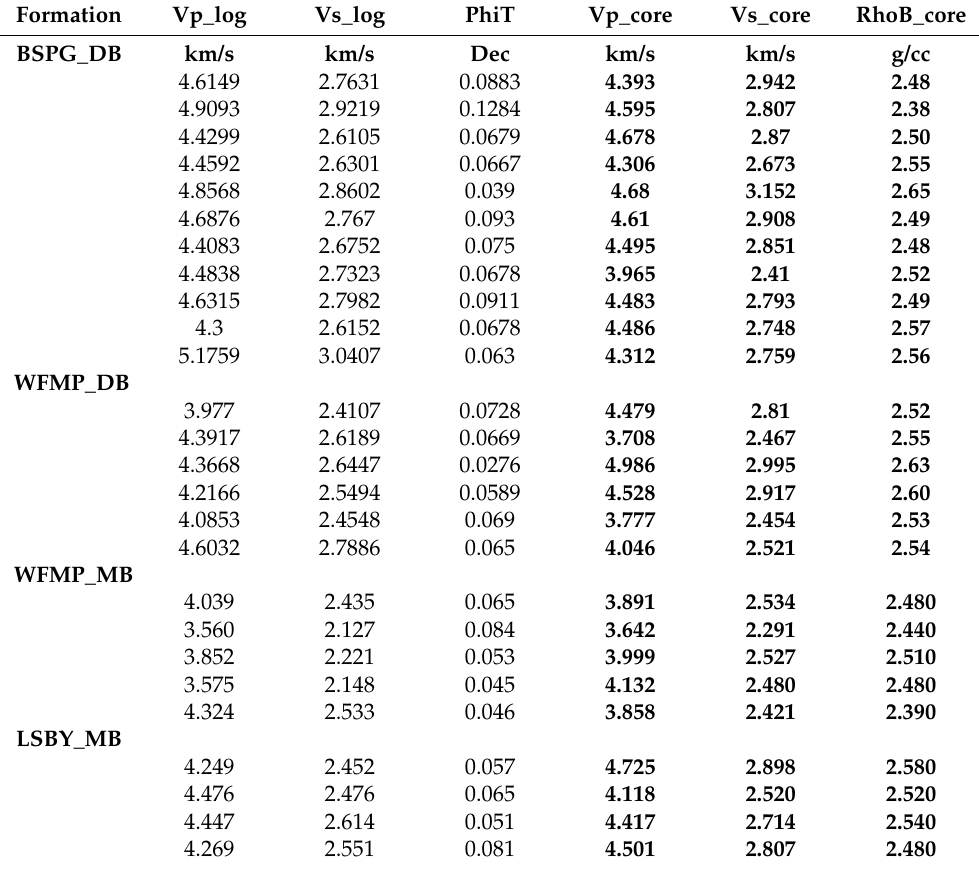
Table A1. Sonic log and ultrasonic core measured P-wave and S-wave velocities for the four for- mations. BSPG_DB is Bonespring formation Delaware basin. WFMP_DB is Wolfcamp formation Delaware basin. WFMP_MB is Wolfcamp formation Midland basin. Furthermore, LSBY_MB is Lower Spraberry formation Midland